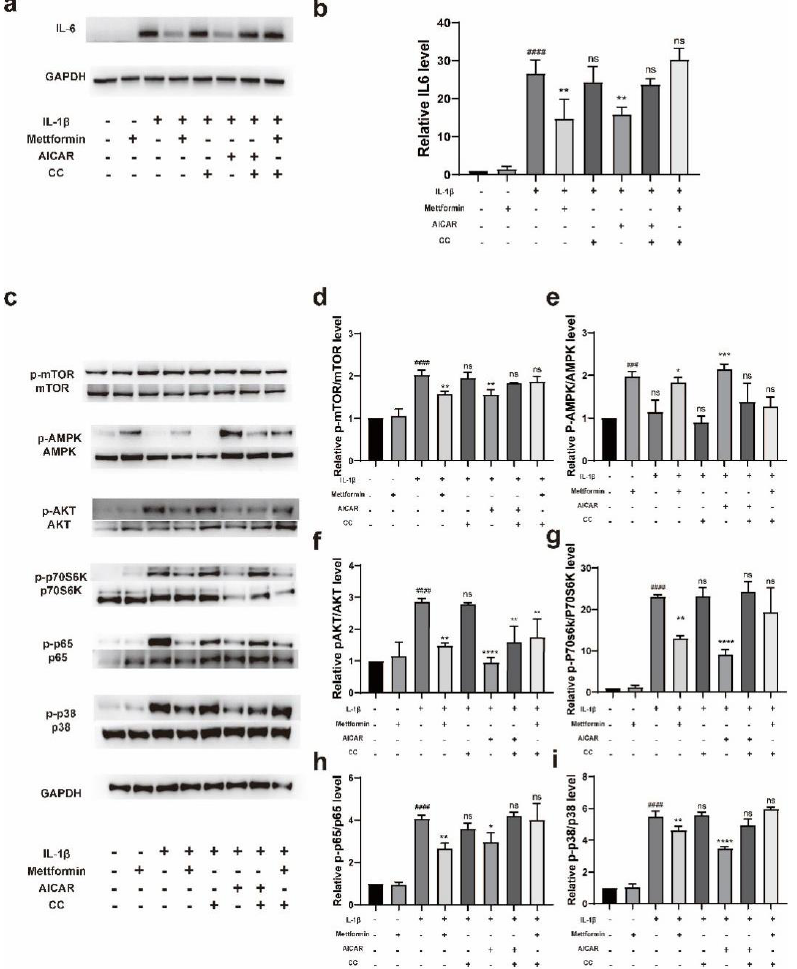
Figure 7. Metformin suppresses inflammation via the AMPK/mTOR signaling pathway. ( a ) TAO- OFs were pretreated with metformin for 24 h and then stimulated with 1 ng/mL of IL- 1β for 24 h. The expression levels of inflammation-associated proteins were determined by Western blotting.